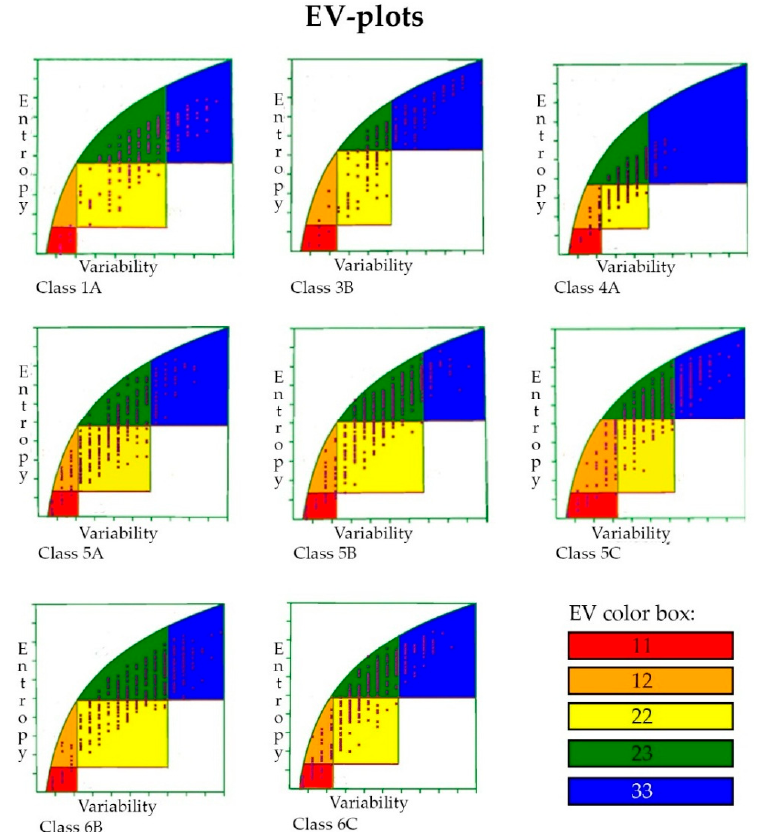
Figure 5. Entropy-variability (EV) plots of the eight subclasses. Red is for those residues likely to be in the main active site; orange is the main active site; green is the regulatory site; yellow communicates; blue is those with unknown function (see the Methods Section for more details).